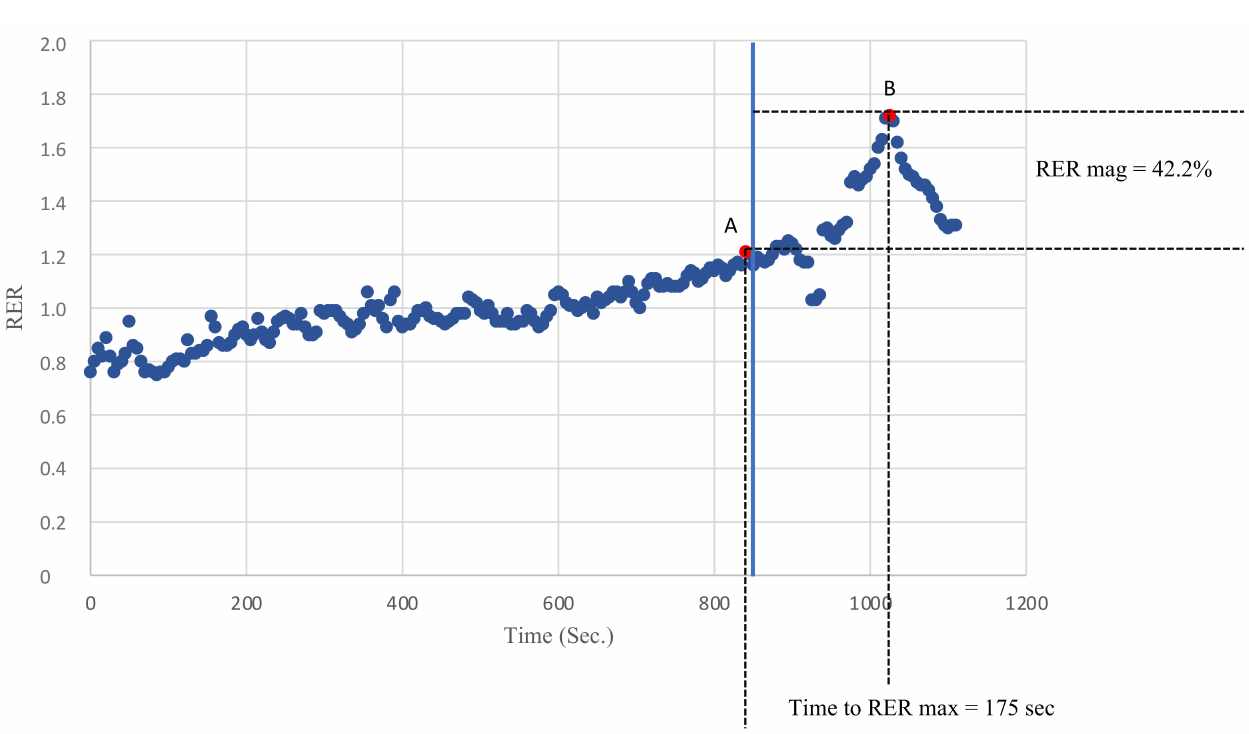
Figure 1. An example of the recovery of the RER in one of the KTRs. Point A defines the peak RER as the highest RER value recorded during exercise. Point B defines the RER max as the highest RER value recorded during recovery. The time to the RER max was defined as the time needed to go from A to B (s). The RER mag was defined as the percentage increase in the RER during recovery compared with the peak